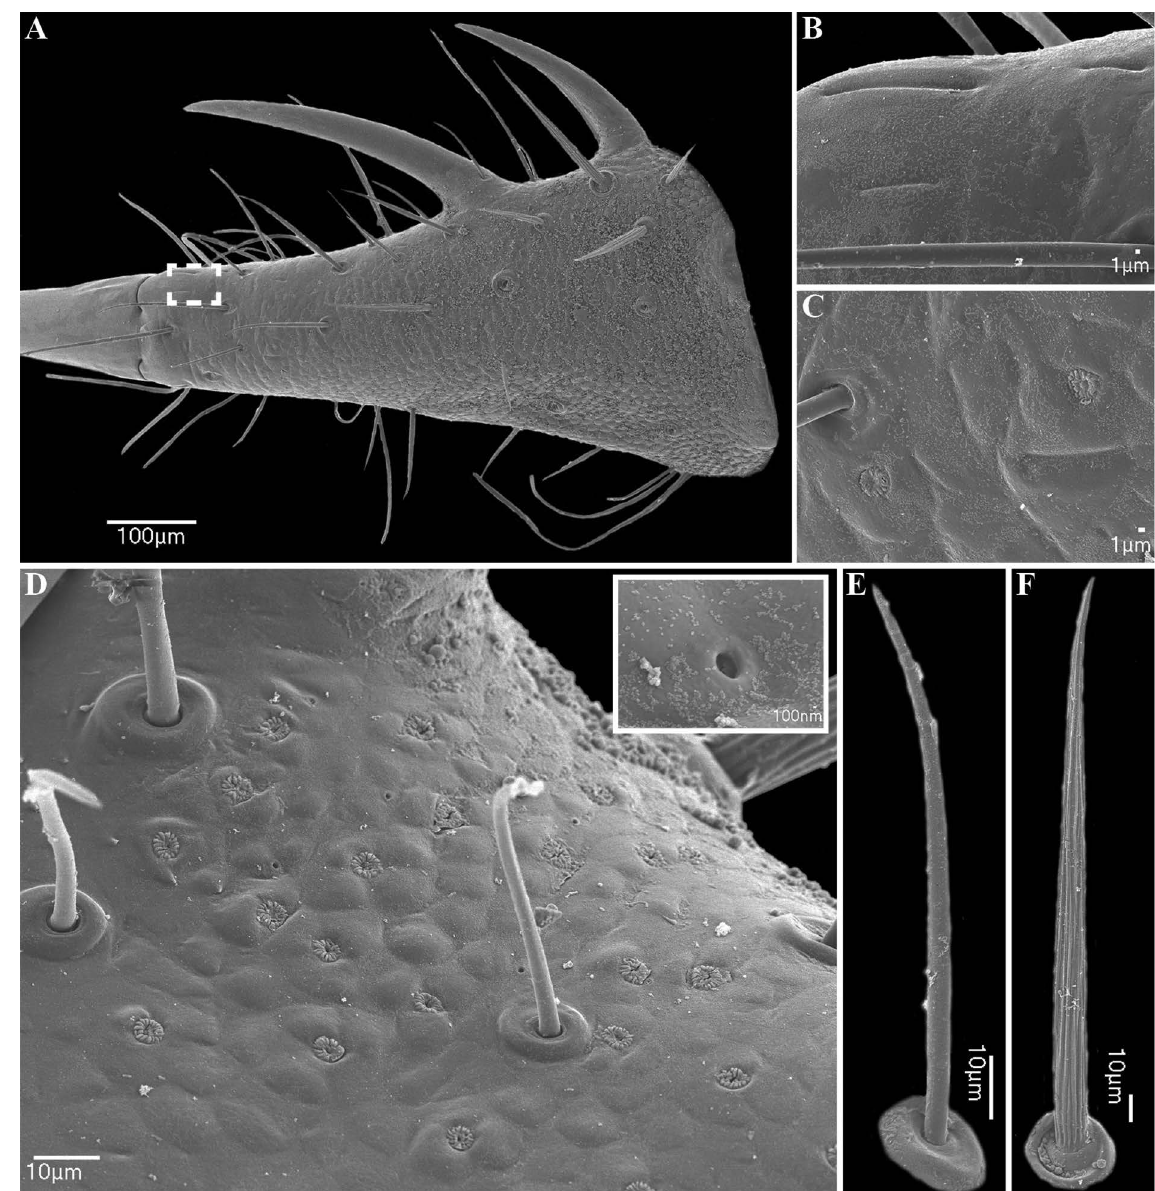
Fig. 86. Charinus africanus Hansen, 1921 (AMCC [LP 6943]), pedipalp tarsus, ♀. A . Tarsus. B . Slit sense organs on tarsus. C . Gland openings on tarsus. D . Multiple gland openings on tarsus. E . Type I setae on tarsus. F . Type II setae on